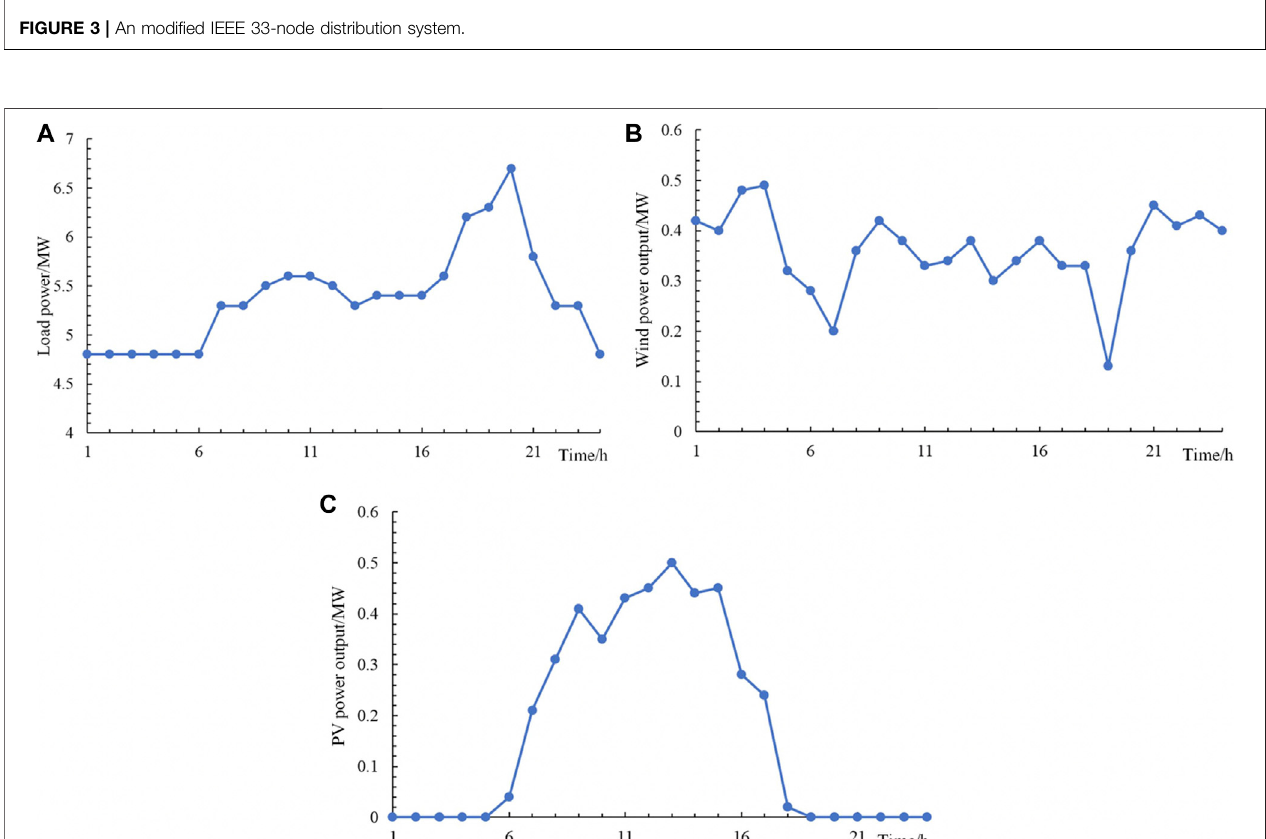
FIGURE4| Theload,PV,andwindpowercurvesonatypicaldayinacertainarea. (A) Theloadcurveonatypical dayinacertainarea. (B) Windpoweroutputona typical day in a certain area. (C) PV power output on a typical day in a certain area.